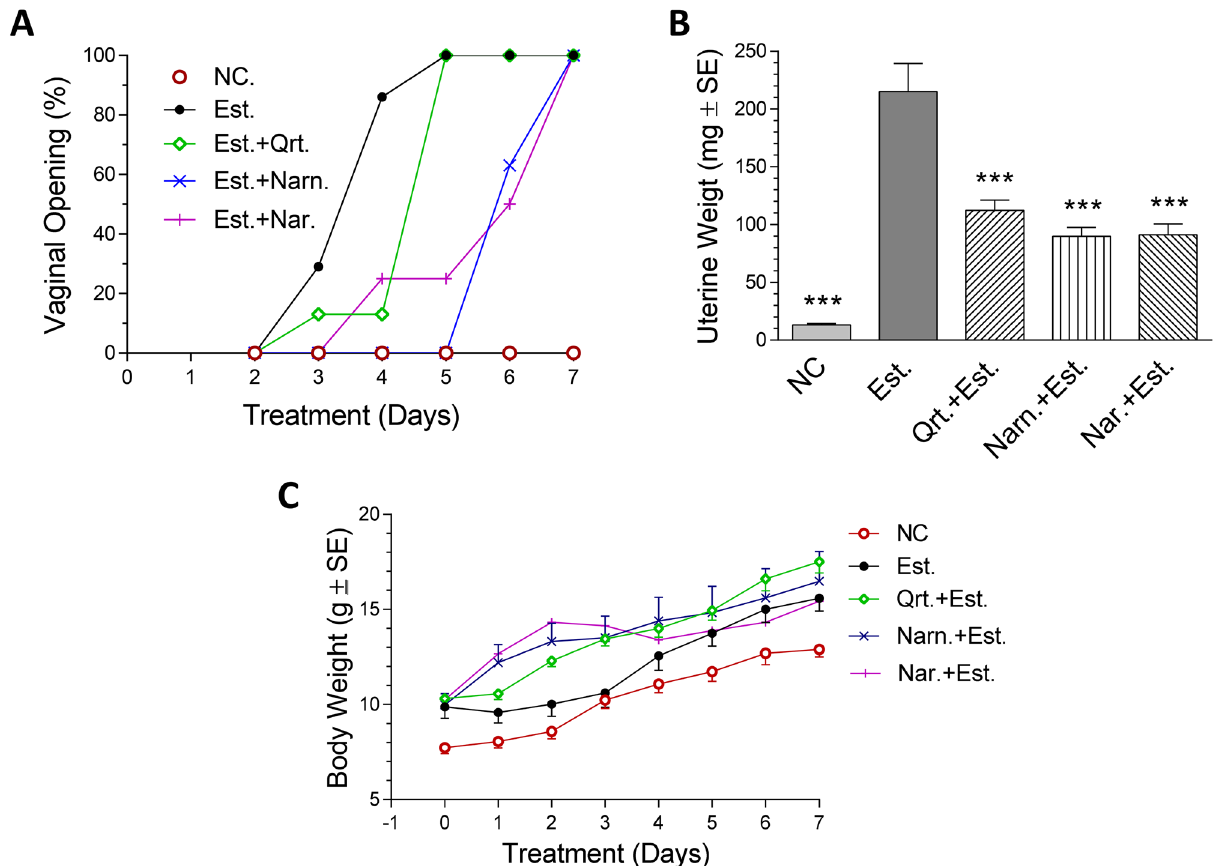
Figure 4. Anti-estrogenic activity of quercetin, naringenin and naringin. ( A ) Vaginal opening (%) for the in vivo anti-estrogenic activity groups of immature female mice. ( B ) Bar chart of average uterine weights (mg ± S.E.) of the in vivo anti-estrogenic activity groups of female immature mice. ( C ) Body weight changes (g ± S.E.) of the in vivo anti-estrogenic activity groups of immature female mice. NC negative control group receiving olive oil s.c., Qrt quercetin, Narn naringenin; Nar naringin, Est. estradiol positive control group. ***Significant at p < 0.0001 compared to Est. using One Way ANOVA followed by Dunnett’s Multiple Comparison test (n = 7–8). For vaginal opening, Log Rank test “Chi Square test” was used (n =